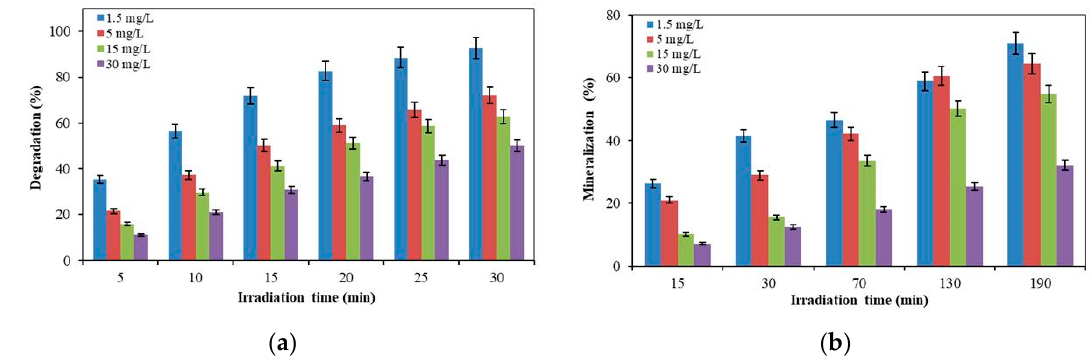
Figure 3. Effect of initial pollutant concentration on the target compound degradation ( a ) and mineralization ( b ) efficiency with 1 g/L of catalyst, maximal irradiation (9.52 mW/cm 2 ), natural solution pH, room temperature.